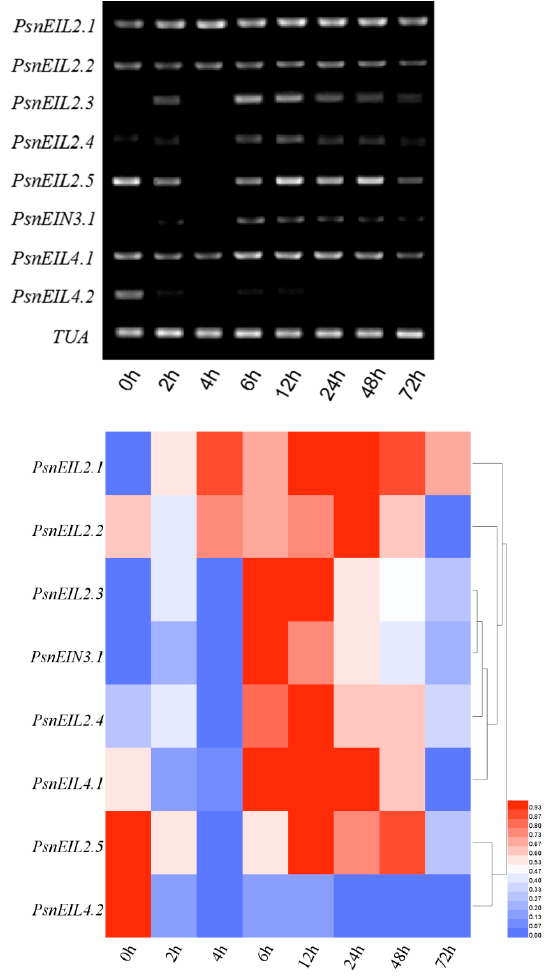
Figure 15. EIN3/EIL gene expression patterns of Populus × xiaohei under ABA